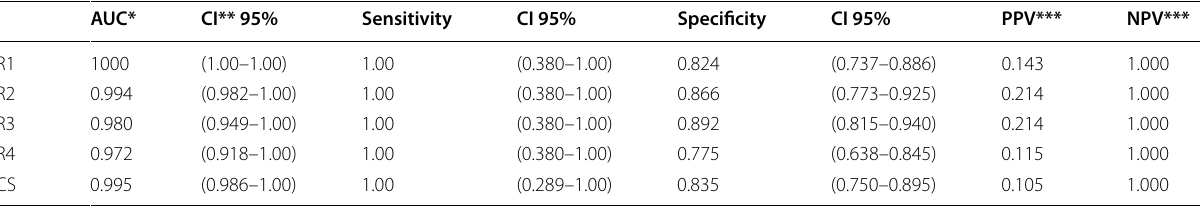
*Area under ROC curve **Confidence